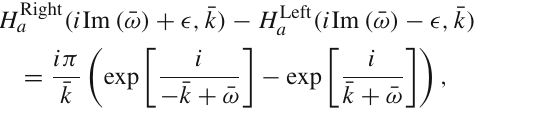
±¯ k , and for a gradient expansion around at ¯ ω = poles and the starting point of branch cuts are not separated.